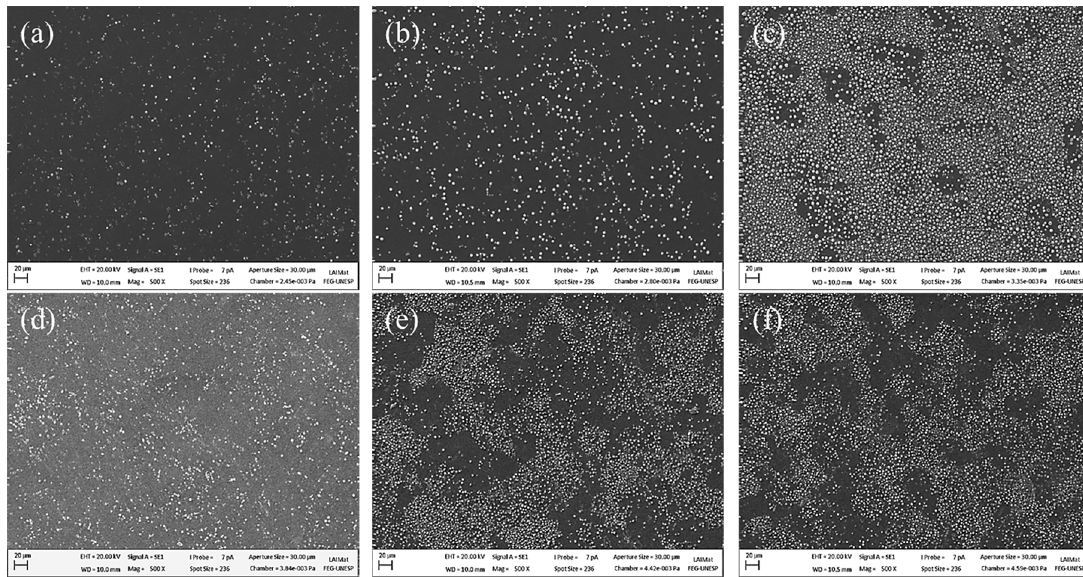
Figure 3. SEM images obtained using a secondary electron detector for electropolished titanium substrates (EP) after anodization at different anodization times: 3 h (a, d), 6 h (b, e), 12 h (c, f); and two electrolyte concentrations (H